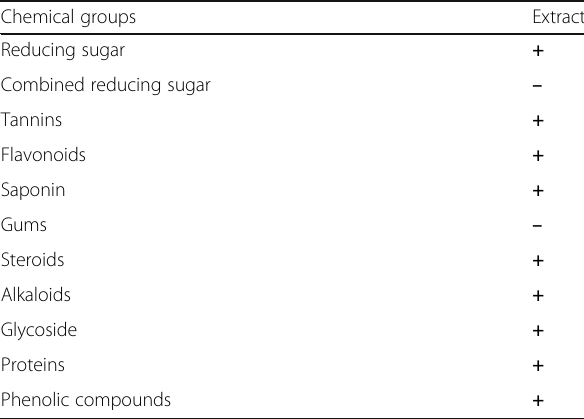
Table 1 Result of phytochemical